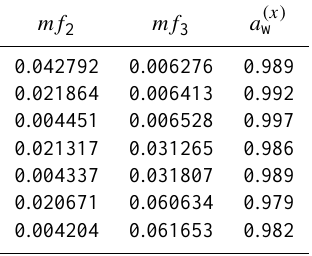
Table A1. Bulk water activity measurements of the system water (1)+oxalic acid (2)+ ( NH 4 ) 2 SO 4 (3) at T = 293 . 15K. Aqueous solution compositions are given in mass fractions ( mf j ).